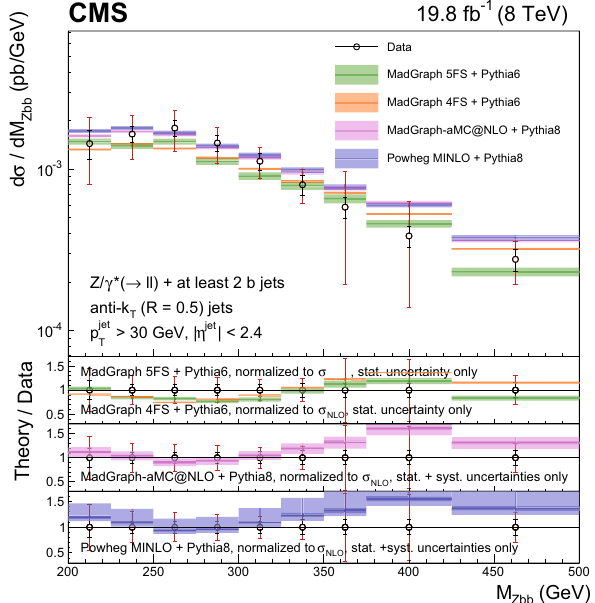
Fig. 14 Differential fiducial cross section for Z(2b) production as a function of Δφ bb , compared with the MadGraph 5FS, MadGraph 4FS, MadGraph5 _a MC@NLO , and powheg minlo theoretical pre- dictions ( shaded bands ), normalized to the theoretical cross sections describedinthetext.Foreachdatapointthestatisticalandthetotal(sum in quadrature of statistical and systematic) uncertainties are represented by the double error bar . The width of the shaded bands represents the uncertainty in the theoretical predictions, and, for NLO calculations, theoretical systematic uncertainties are added in the ratio plots with the inner darker area representing the statistical component